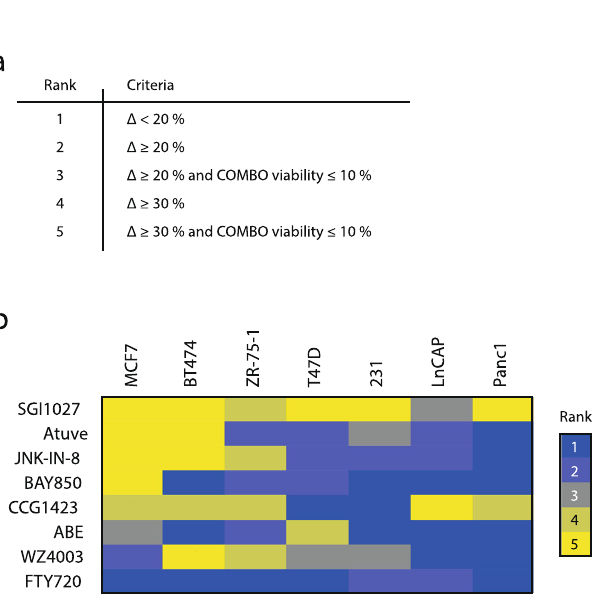
Fig. 4 Combo ef fi cacy ranking. a Criteria associated with its rank. The ranking range is 1 – 5, where 1 represents the lowest level of additive killing effect and 5 represents the highest. b Eight compounds tested in combination with SI-12 on seven cancer cell lines (Figs. 3d, 5, and 6). The additive killing effect was heat-mapped according to the combo ef fi cacy ranking in ( a